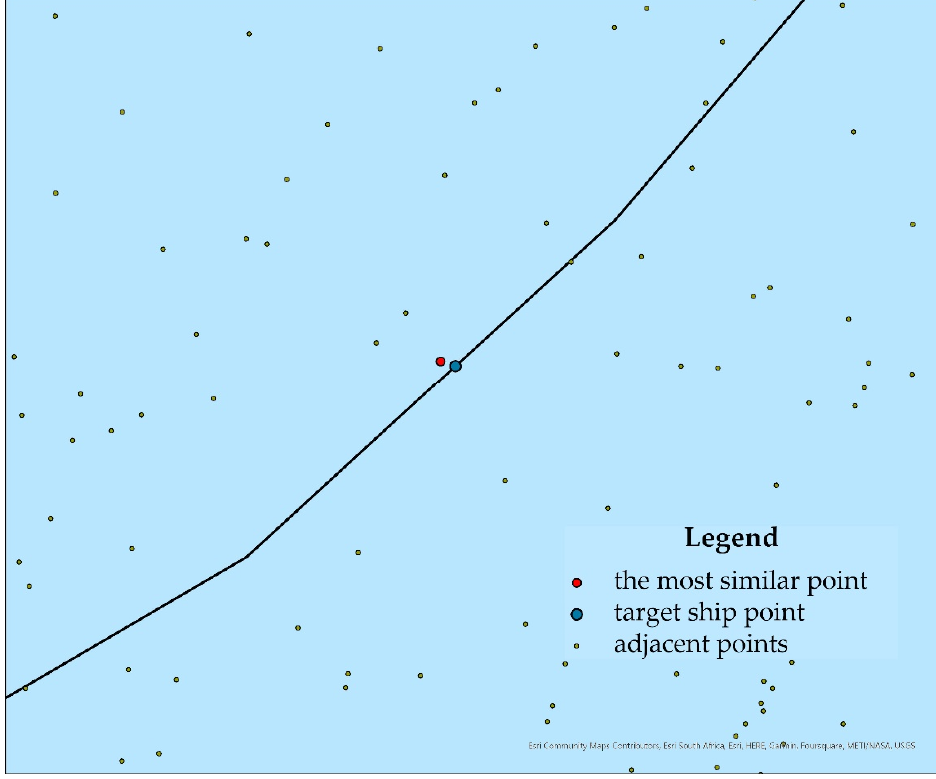
Figure 4. Example of the most similar point retrieved among similar points.